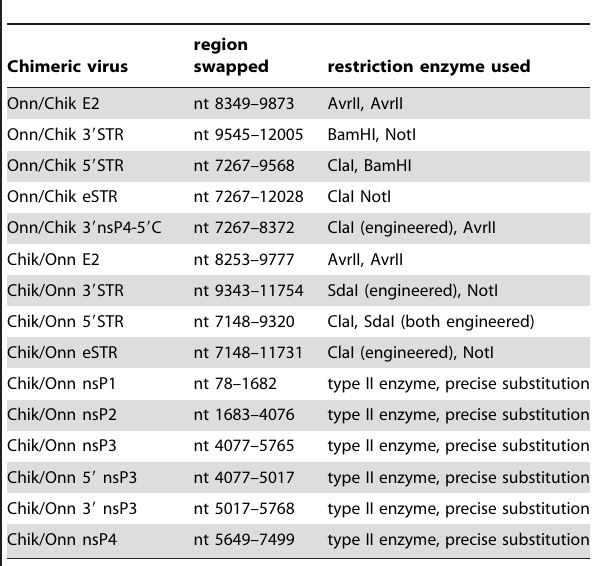
Table 1. Restriction enzyme sites used to create infectious plasmid